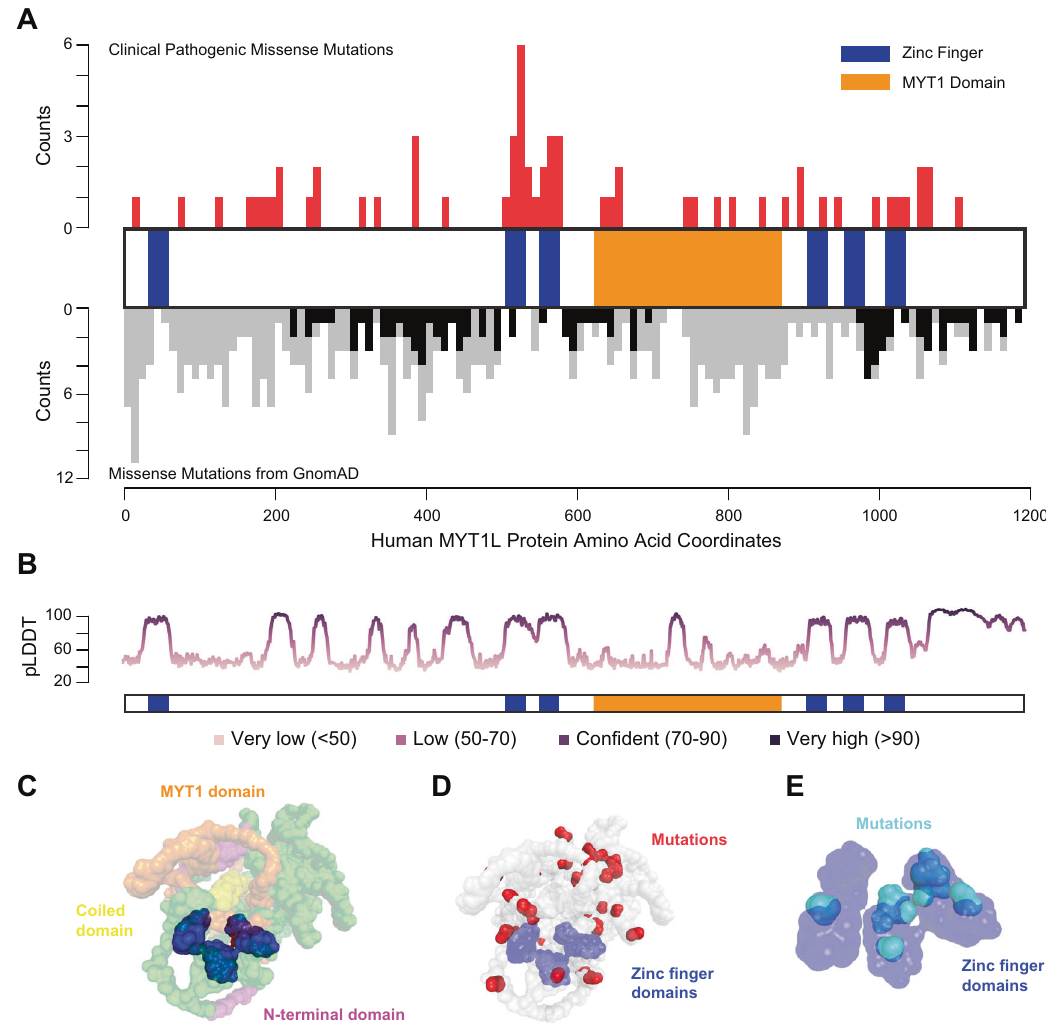
Fig. 1 Schematic of human MYT1L domains and predicted protein structure by AlphaFold. A Distribution of missense mutations described in clinical studies (top, red) compared to a general population sample (gnomAD, bottom, with gray bars displaying all missense mutations and black bars displaying ‘ possible damaging mutations ’ as predicted by PolyPhen2). ‘ Possible damaging mutations ’ in the general population are largely excluded from the regions mutated in clinical samples. B AlphaFold ’ s calculated con fi dence measure (pLDDT score) per-residue of the model ’ s prediction based on the IDDT-C α metric. C 3D AlphaFold structure (AF-Q9UL68-F1) prediction of MYT1L protein showing the N-terminal domain (magenta), MYT1 domain (orange), coiled domain (yellow), and six zinc fi nger domains (blue) coming in proximity with each other to form a putative DNA-binding pocket. Unannotated regions are shown in green. (https://alphafold.ebi.ac.uk/entry/Q9UL68). D Loss of function mutations from patient reports are found throughout the protein. Those not within the annotated zinc fi nger domains (blue) are shown in red. E Isolated and magni fi ed view of the zinc fi nger domains (blue) shows patient mutations (cyan) cluster in the zinc fi